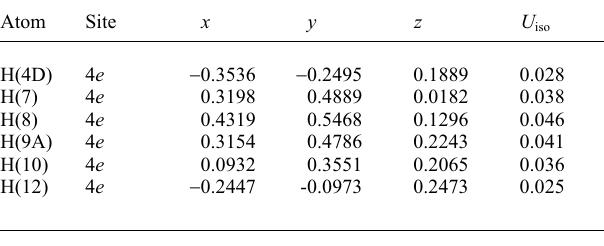
Table 3. Atomic coordinates and displacement parameters (in Å 2 )